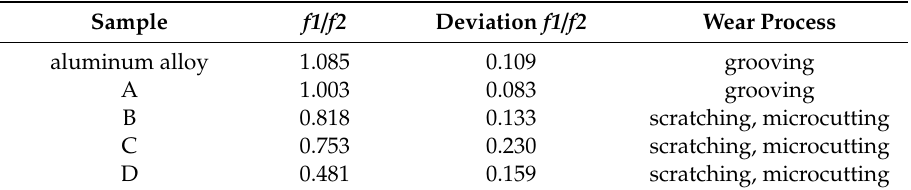
Table 5. Values of ration of cross-sectional surface area of material upsetting around Scratch f1 and recess of Scratch